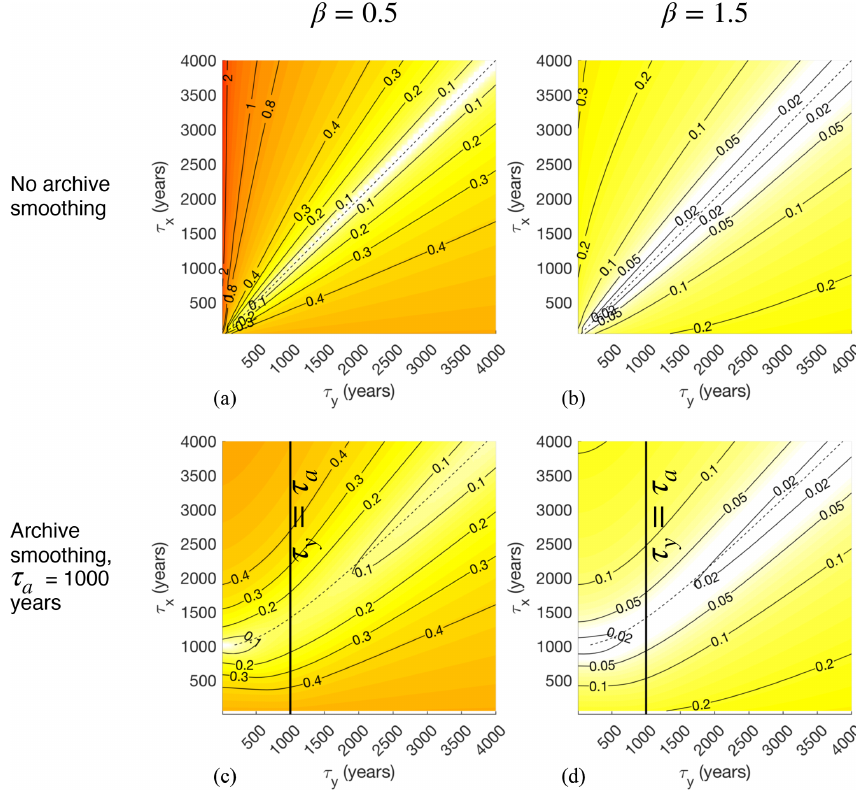
Figure 5. Error-to-signal fractions f for time-mean estimates plotted as a function of target averaging interval τ x and observation averaging (cid:12) (cid:12) 2 ∝ ν − β ) with spectral slopes β equal to 0.5 (a, c) and 1.5 interval τ y . Climate signal spectra are power-law functions of frequency ( (cid:12) ˆ r ( ν ) (cid:12) (b, d) . Panels (a–b) correspond to a case with no archive smoothing ( τ a = 0), while panels (c–d) correspond to a case in which the signal r ( t ) is smoothed by a running mean over τ a = 1000 years. Values to the left of the bold line at τ y = τ a lie in the “smoothed regime” wherein archive smoothing qualitatively affects results. Timescales were chosen to be relevant to the problem of time-mean estimation at the Last Glacial Maximum, ca. 20ka. Dotted lines show values of ˜ τ y derived to minimize error estimated according to Eq. (A20).